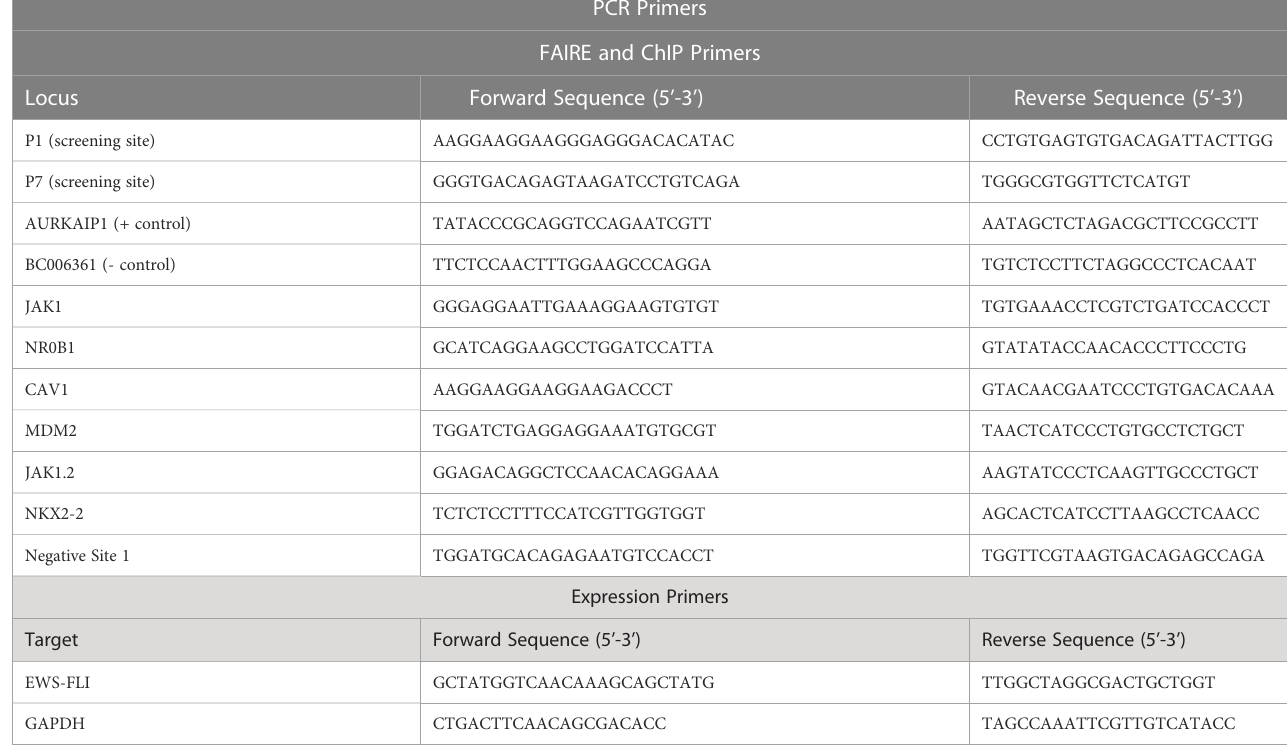
TABLE 2 PCR primers used in these